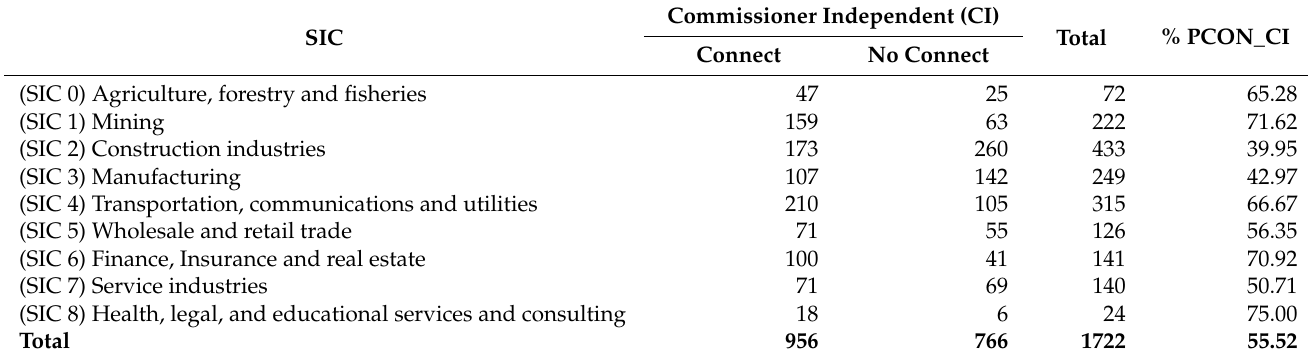
Table 2. Distribution of Politically Connected Independent Commissioners Based on Standard